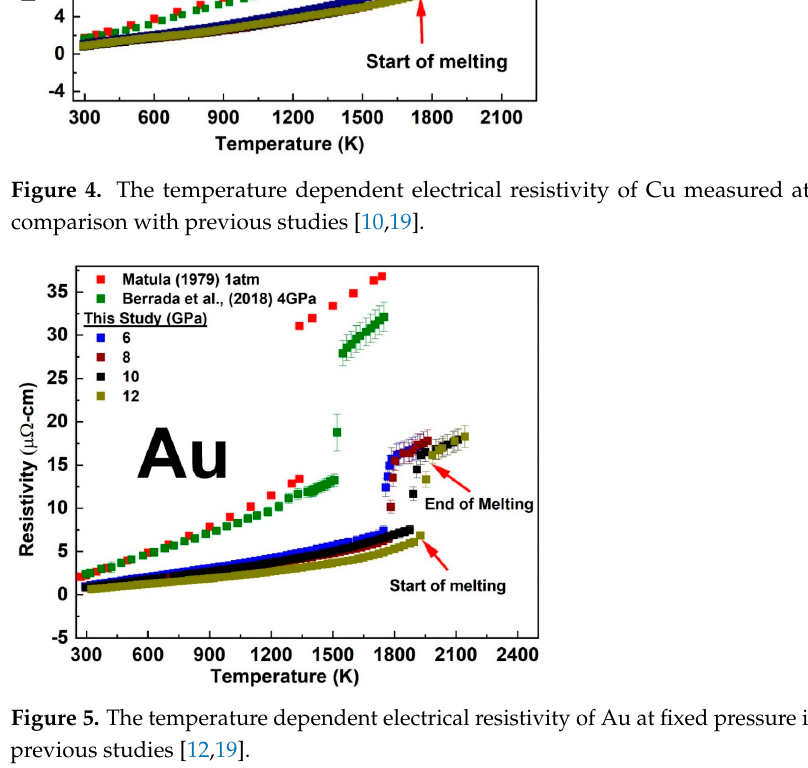
Table 1. Tabulated fitting parameters at various fixed pressures for Cu runs.